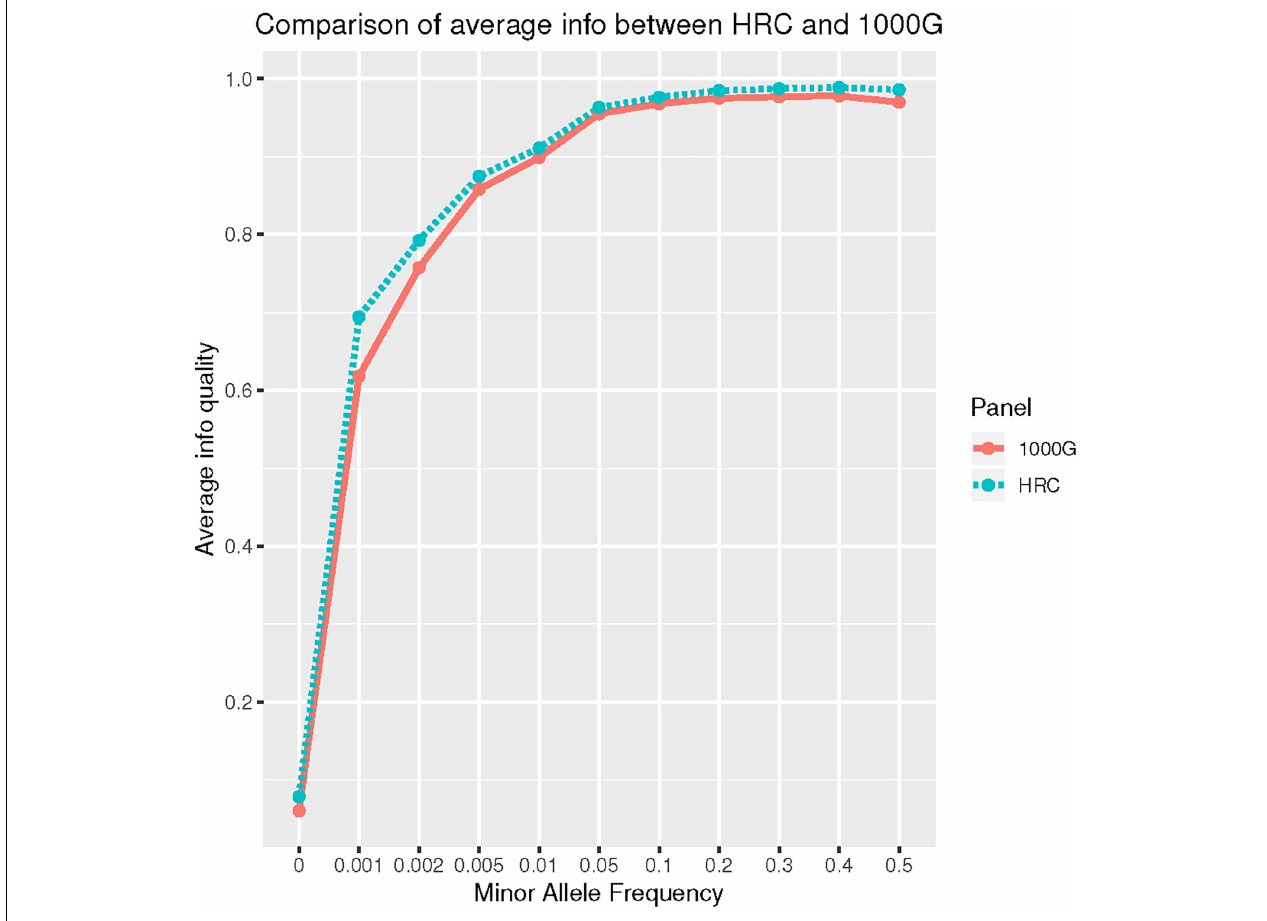
FIGURE 1 | Comparison of average Info quality between HRC and 1000G reference panel for all autosomal chromosomes.